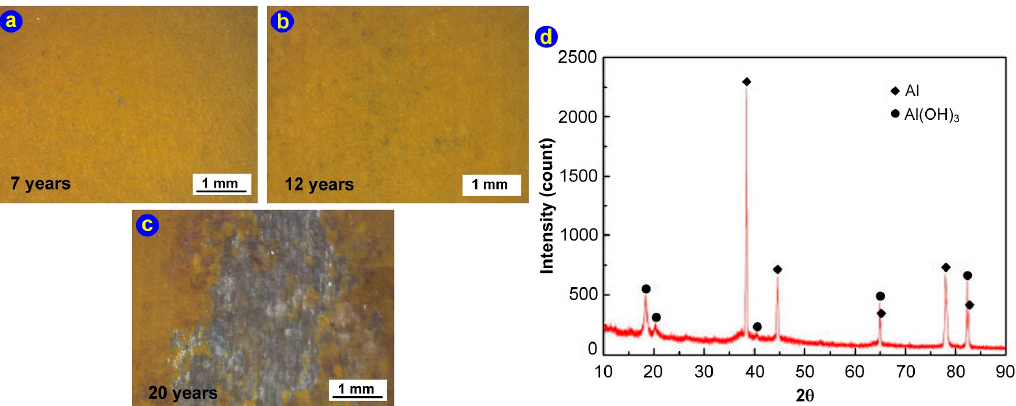
Figure 3. Analysis of the surface morphology and composition of the products of corrosion of epoxy primer-coated aluminum alloy exposed in the field. ( a – c ) Surface morphology of specimens exposed for 7, 12, and 20 years. ( d ) XRD analysis of the products of corrosion in the area of exfoliation corrosion of the specimen exposed for 20